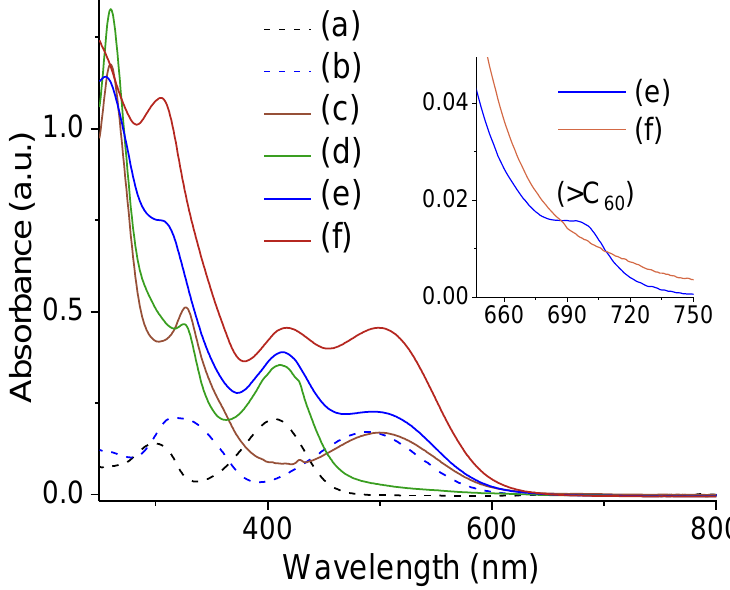
Figure 6. UV-vis spectra of ( a ) BrDPAF-C ( d ) C (>DPAF-C 60 4 , in chloroform at a concentration of 1.0 × 10 −5